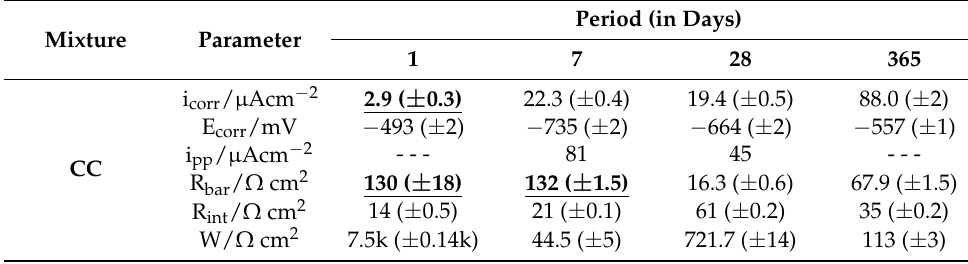
Table 5. Polarization and impedance parameters of the CC, SAND and CEM samples in distinctive immersion